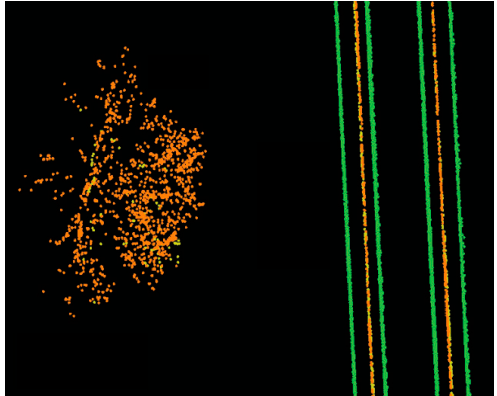
Figure 9. Topological relationship among railroad infrastructure in which points belonging to rail tracks, class 2, and class 3 are depicted in green, yellow, and brown color, respectively. When all points are projected onto a planimetric plane, the overhead cables appear as straight linear objects between each pair of rail tracks and the catenary cables lie exactly on top of contact cables.